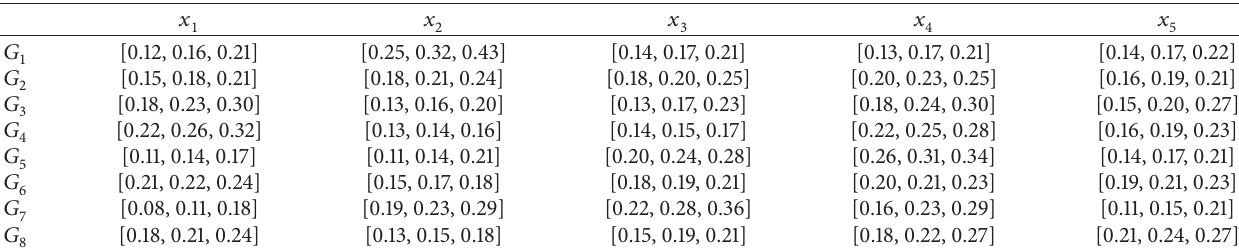
Table 4: Normalized triangular fuzzy number decision matrix 𝑅 (1) .